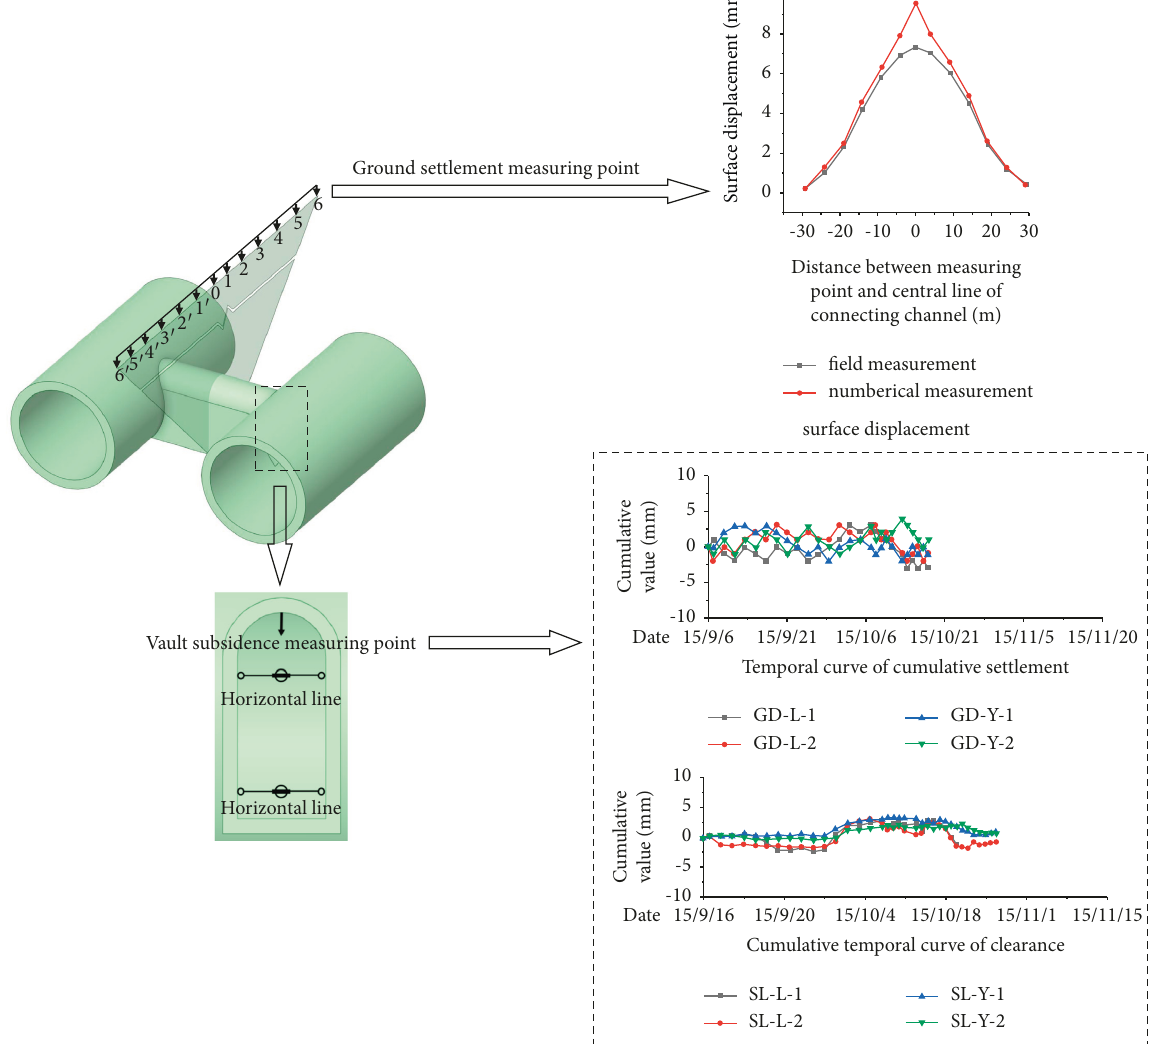
Figure 11: The cross-sectional view and the freezing hole layout and freezing wall design parameters of the 2-line contact channel between Nationalities University Station and Qingchuan